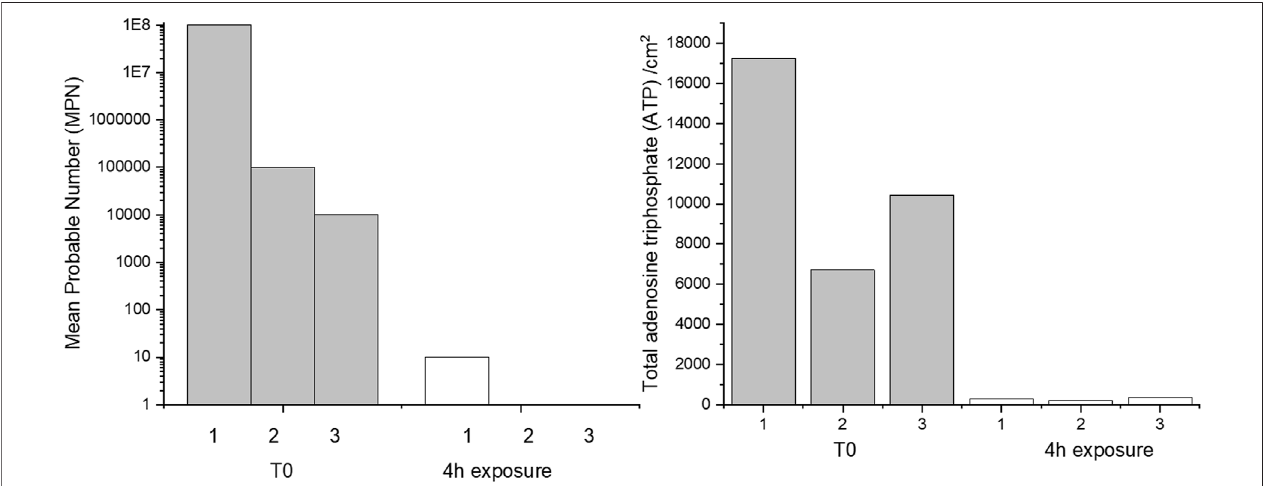
FIGURE 2 | Triplicate mean probable number (MPN, left) and tATP measurements (right) taken from before (T0) and after 4 h of exposure to CTA-4OHcinn.